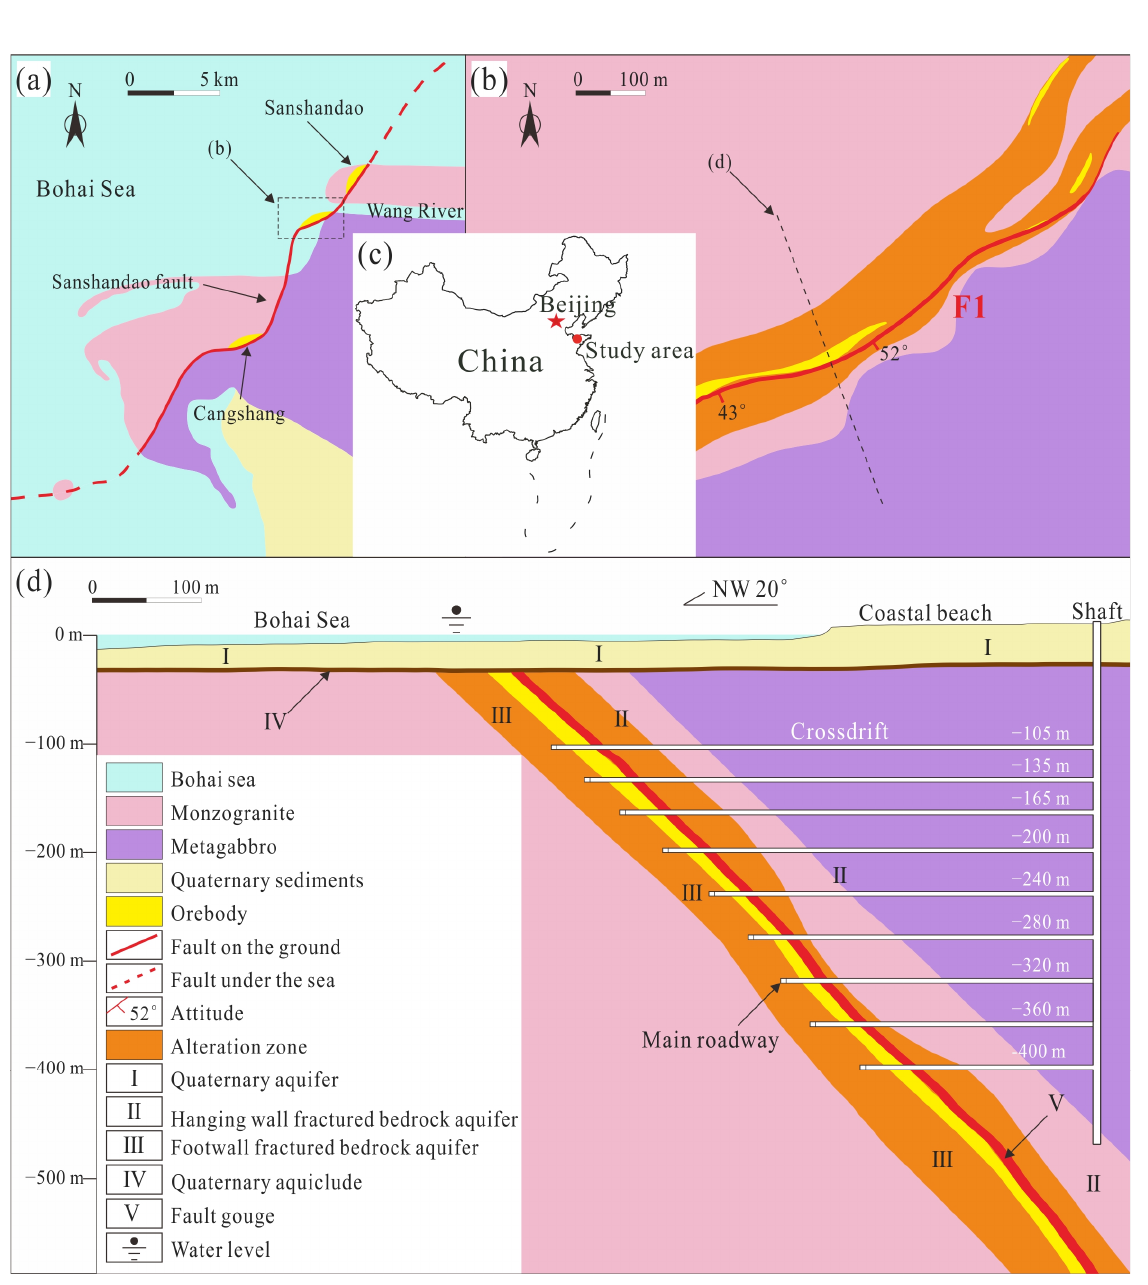
Figure 1. Engineering geological map of Sanshandao Mine. ( a ) Simplified geologic map showing the Sanshandao fault and other features; ( b ) close-up geologic map of the Xinli gold deposit area showing the fault and cross-section location; ( c ) location of the study area in China; ( d ) cross-section showing the fault, geology, and hydrogeologic features, as well as the underground workings of the Xinli gold deposit.